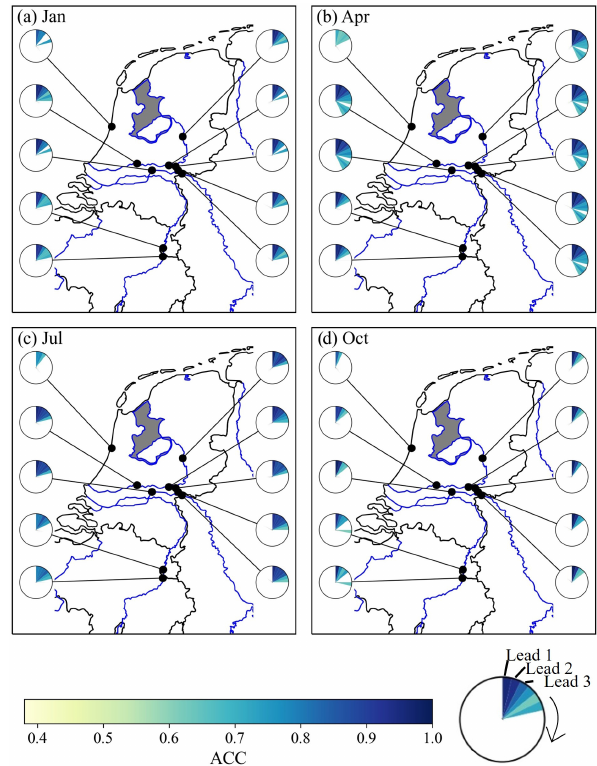
Figure 5. Anomaly correlation coefficient (ACC; weekly) for (a) January, (b) April, (c) July, and (d) October, for discharge hind- casts computed by the RF model, showing the results for differ- ent stations (limited selection for visual purposes) in the national monitoring network. Only significant values are shown (indicated by a range of 0.4 and higher). Furthermore, only major river net- works are shown, and smaller streams or infrastructures are not highlighted (the station along the coast is placed at a sluice along a stream). Maps were created using the Python package Cartopy (Elson et al., 2022), which uses basemap data made with Natural Earth and © OpenStreetMap contributors 2022. Distributed under the Open Data Commons Open Database License (ODbL)